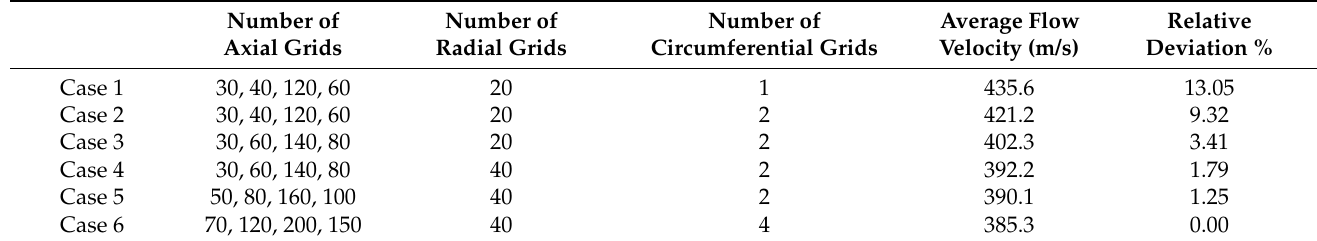
Table 1. Effects of grids on the mean molecular velocity at the nozzle exit.